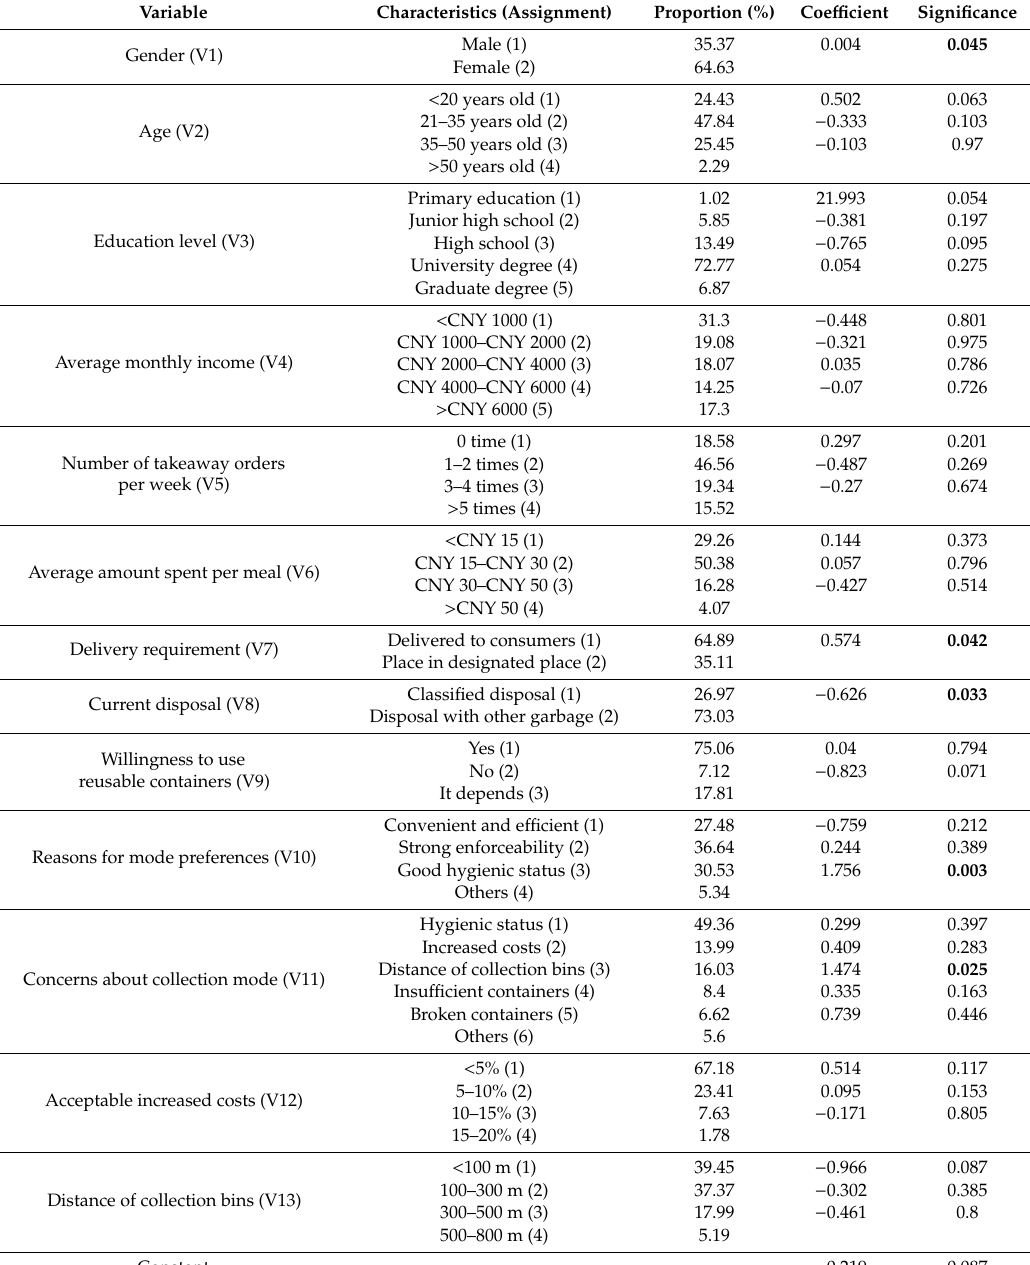
Table 3. Characteristics of the consumer survey samples and the regression analysis results of the consumers’